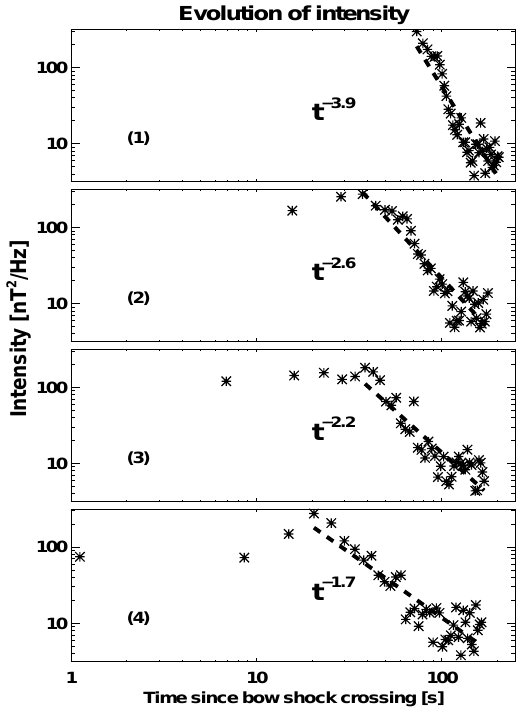
Fig. 11. Evolution of the intensity with time after the bow shock crossing (the numbers (1) to (4) in the panels correspond to the streamlines in Fig. 9). The x-axis is relabelled from Fig. 10 us- ing Taylor’s hypothesis. The asterisk symbols denote the observed intensities. The decaying part is fitted by a power law (dashed